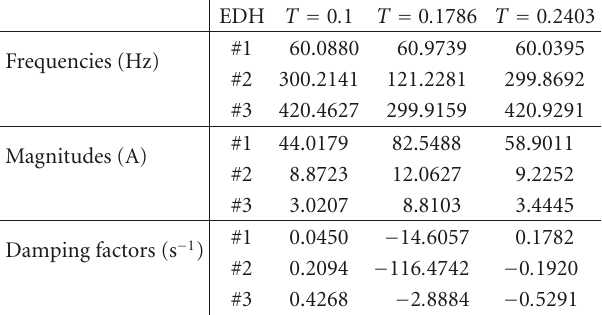
Table 2: Estimated dominant harmonics (EDH) of